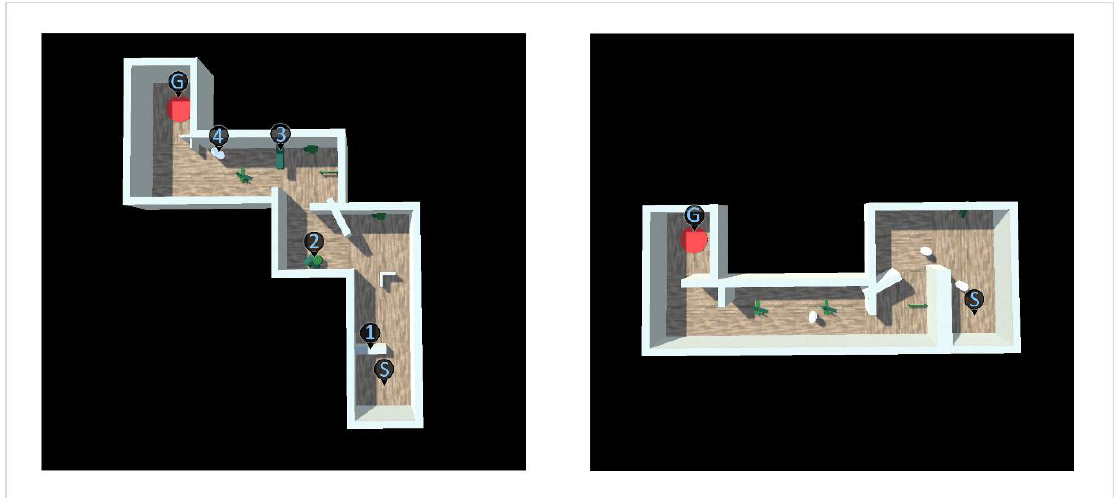
Figure 3. Top-down view of two examples of the randomized obstacle parkour used in the navigation task. The letter S indicates the starting point, the red circle marked with a G indicates the goal of the parkour. The blue digits mark examples of the four different obstacle types: 1 = large static obstacle/wall; 2 = low-height obstacle; 3 = obstacle hanging from ceiling; 4 = pedestrian.